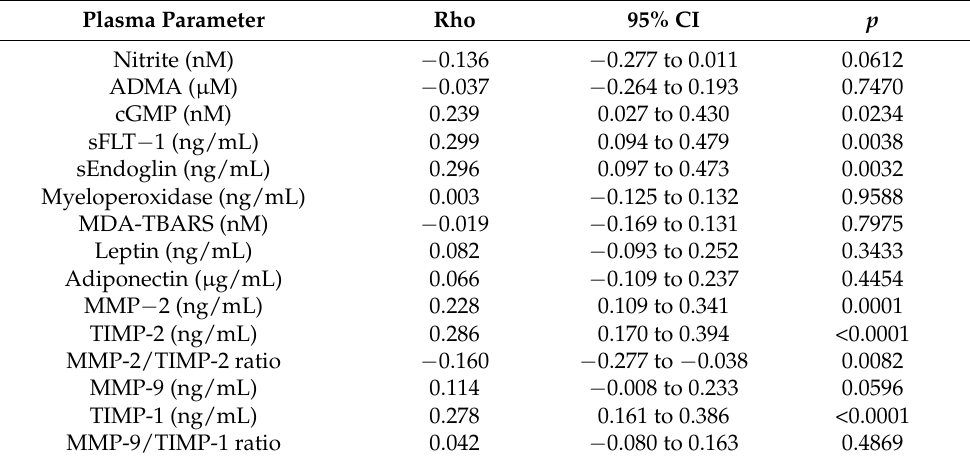
Table 4. Relationships between total cfDNA and circulating factors in all studied